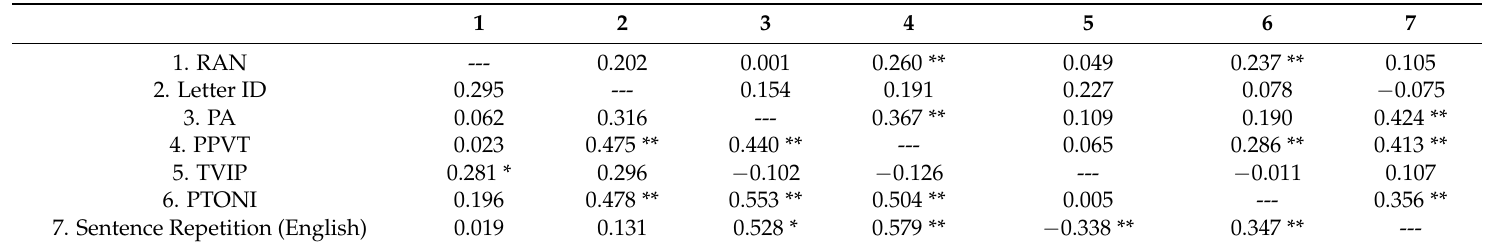
Table 5. Relationships between RAN and raw scores on language, early literacy and non-verbal intelligence